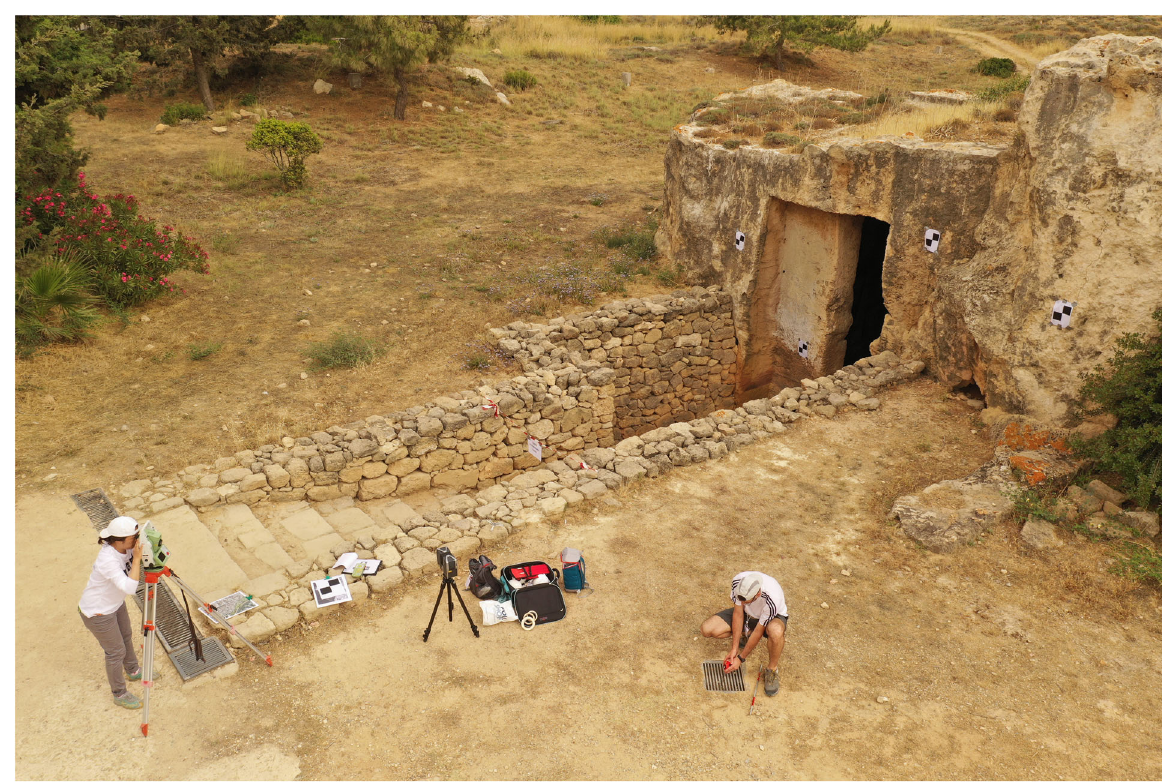
Fig. 2 Documenting an archaeological site using different recoding techniques (Source: the